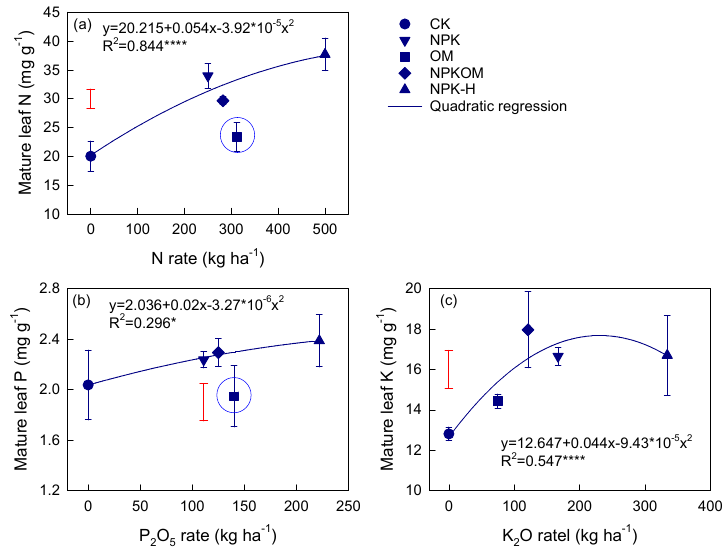
Figure 2. Response of concentrations of N ( a ), P ( b ), and K ( c ) in mature leaves to the rate of fertilizers. Single bars in red without data point are LSD values indicative of significant difference among treatments. Quadratic regression lines are indicated with equations, R 2 values, and significance levels (*, p < 0.05; ****, p < 0.0001). The circled data (OM treatment) were not included in the regression analysis for the significantly low bioavailability of N and